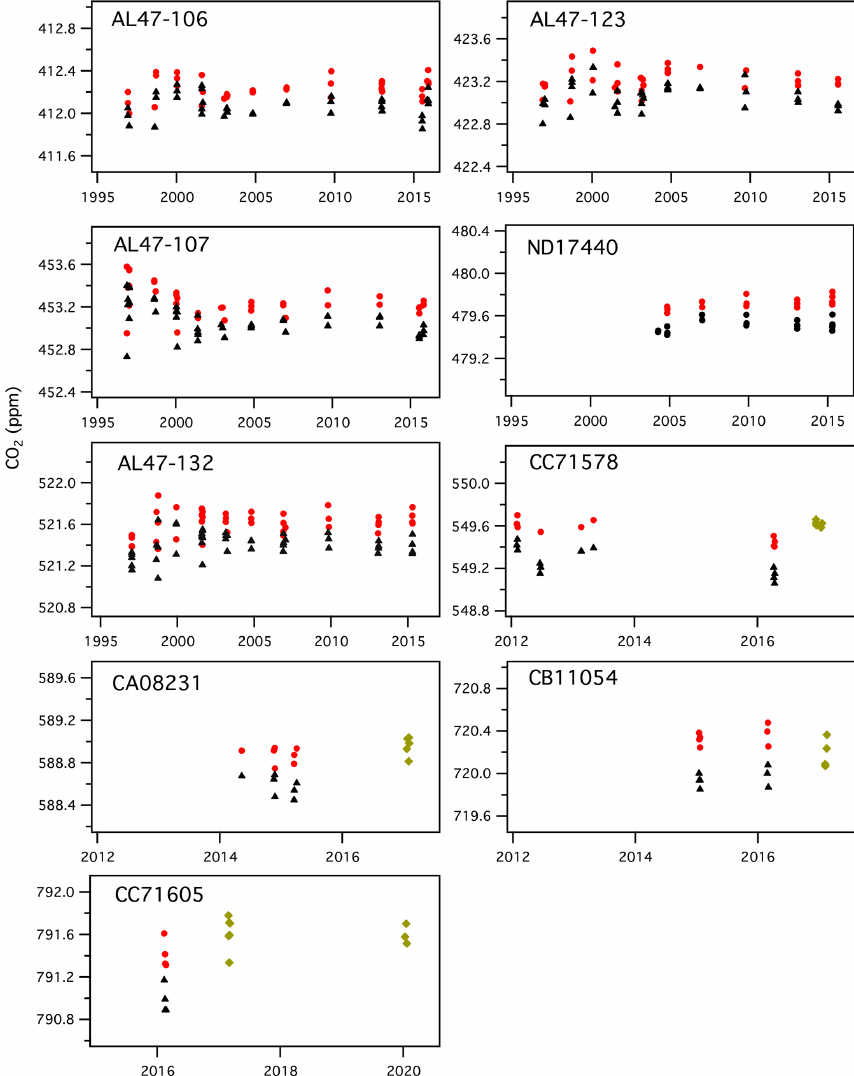
Figure 7. History of manometric results, showing CO 2 (ppm) from the manometric database before corrections (black triangles), CO 2 values after applying X virial and X loss_correction (red circles), and results from 2017 and 2020 for which the second virial coefficient β CO was calculated correctly and only the loss correction was applied (green diamonds). Note that cylinders CC71578, CA08231, CB11054, and CC71605 have a shorter measurement